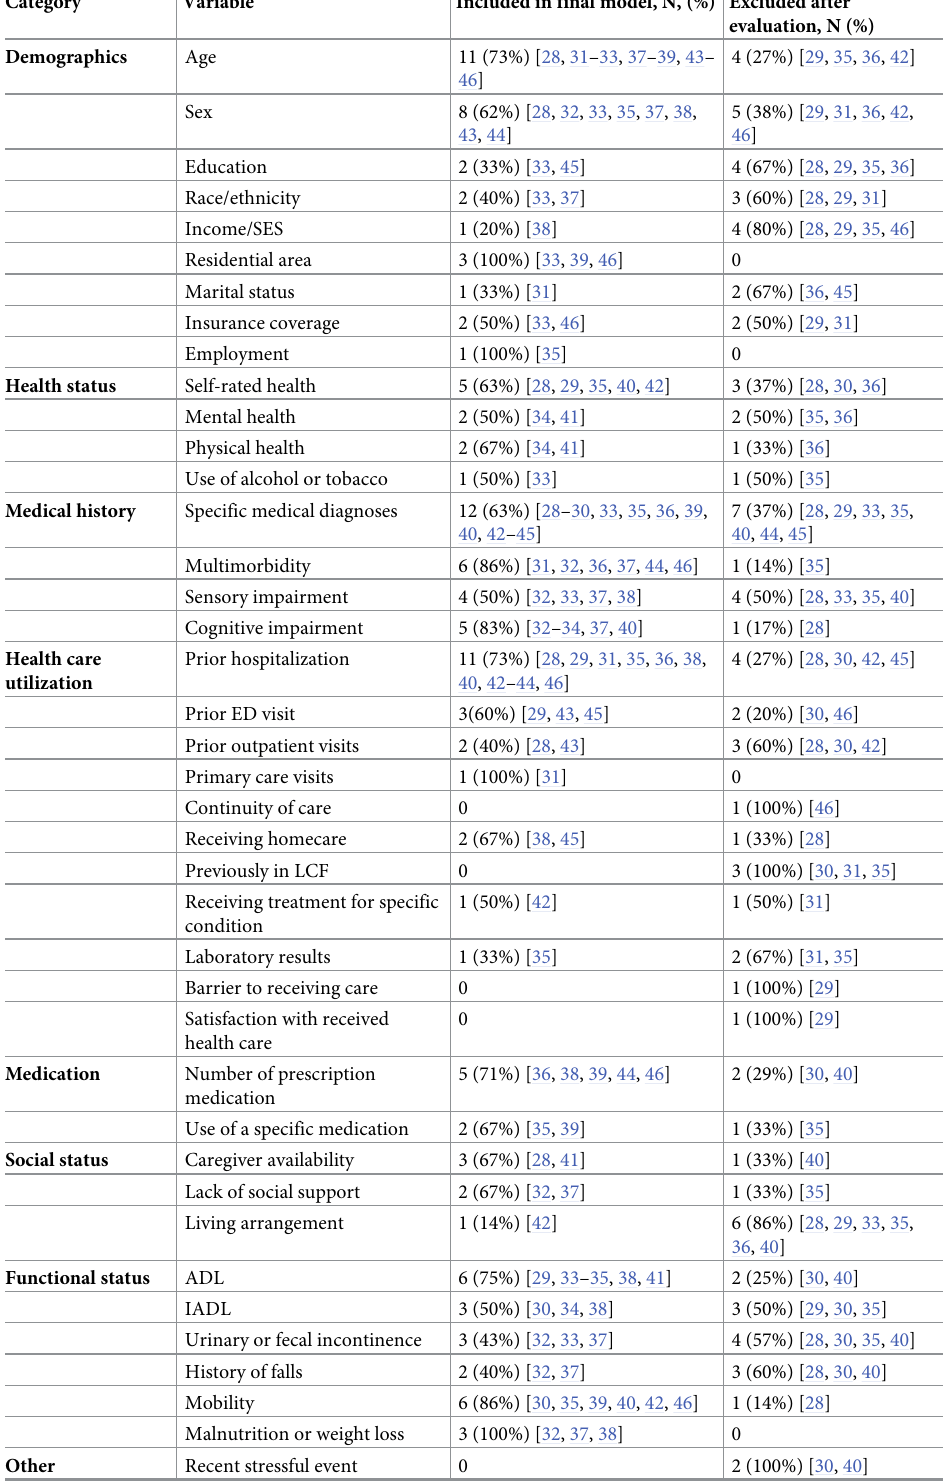
Table 3. Variables included in and excluded from the